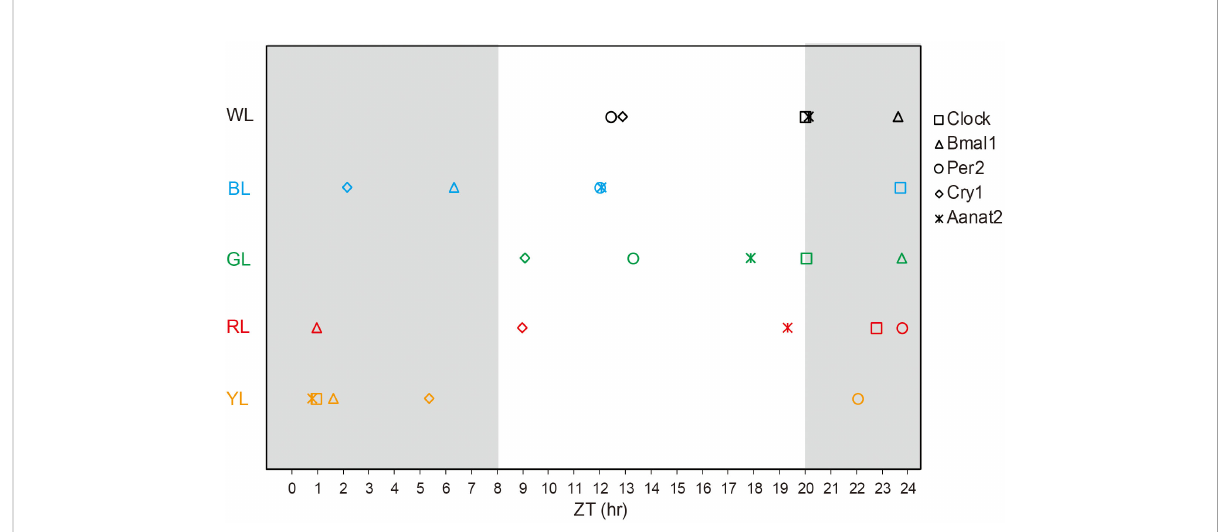
FIGURE 4 Acrophase of the transcription of clock genes and Aanat2 in the brains under different light treatments. The acrophase was done from the data presented in Table 2. The white background indicates the light time; the dark background indicates the dark time. ZT, zeitgeber time; WL, white light; BL, blue light; GL, green light; RL, red light; YL, yellow